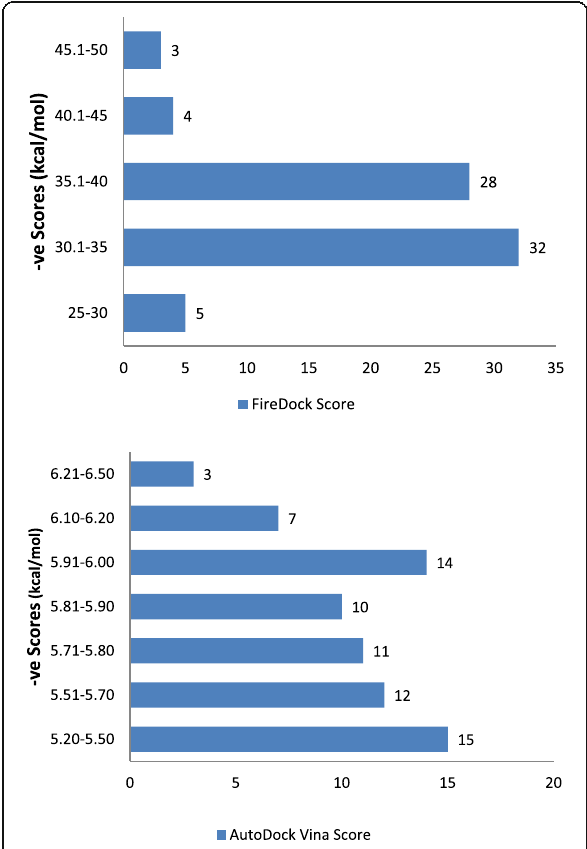
Fig. 1 Frequency distribution of twelve DHB and six proteins over the range of FireDock and AutoDock docking scores